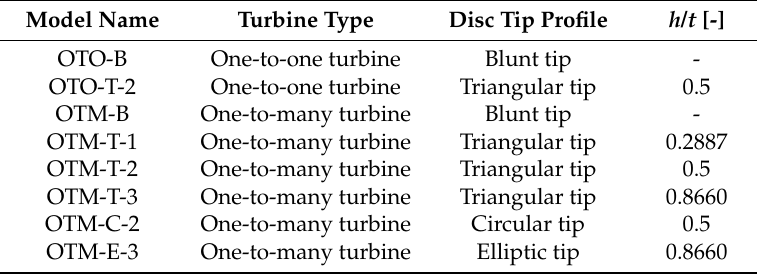
Table 1. Detailed geometrical parameters of disc tips for each turbine